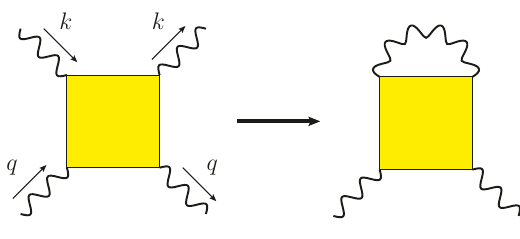
Figure 2 . Cottingham-like formula for QCD LbL